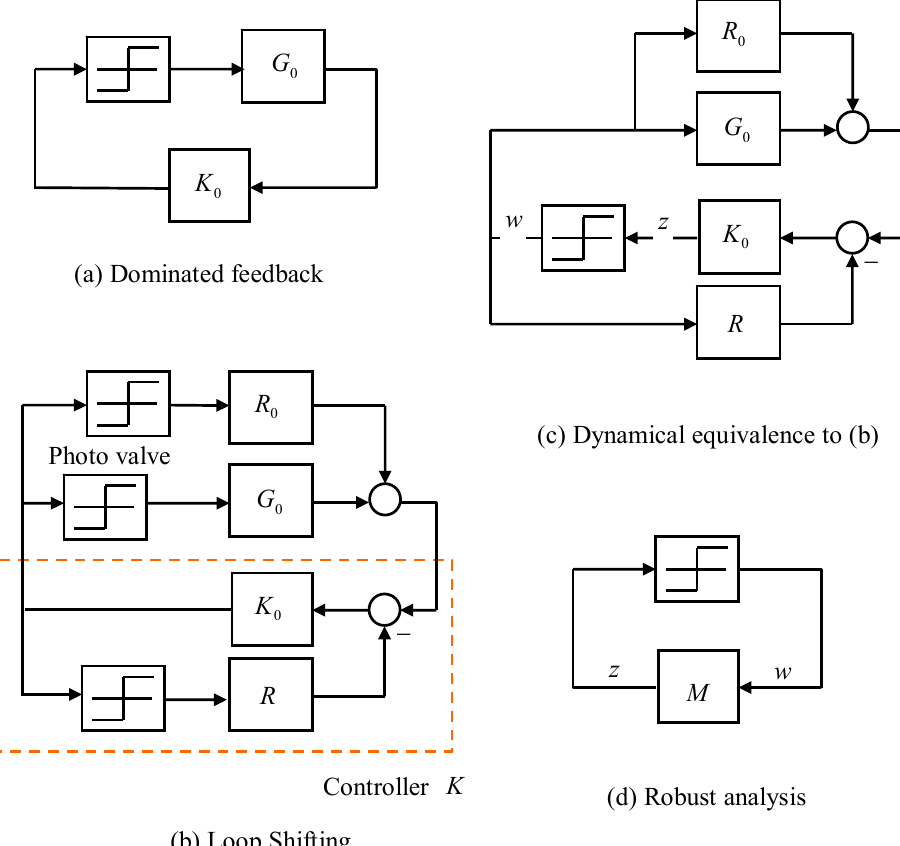
Figure 8. Synthesis of feedback frequency modulator. ( a ) Dominated feedback; ( b ) Loop Shifting ; ( c ) Dynamical equivalence to ( b ); ( d ) Robust